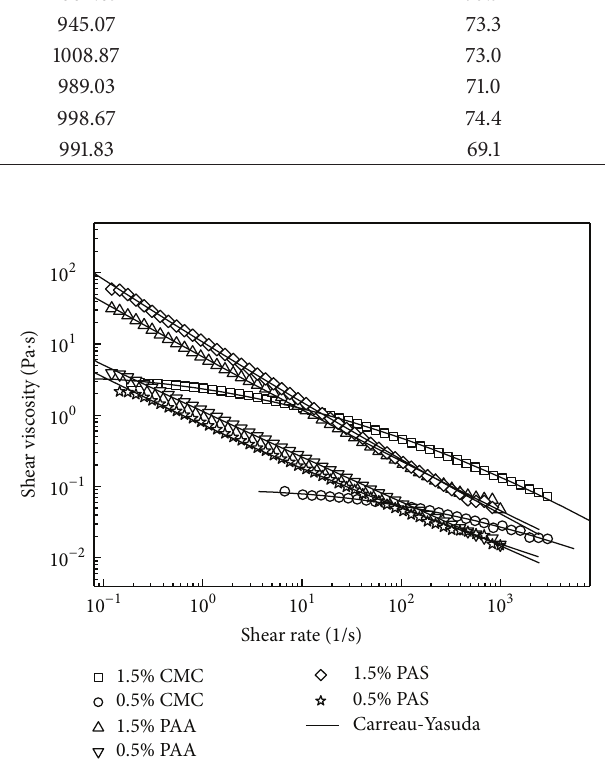
Figure 3: The shear viscosity as a function of the shear rate for the studied solutions and Carreau-Yasuda model fitted